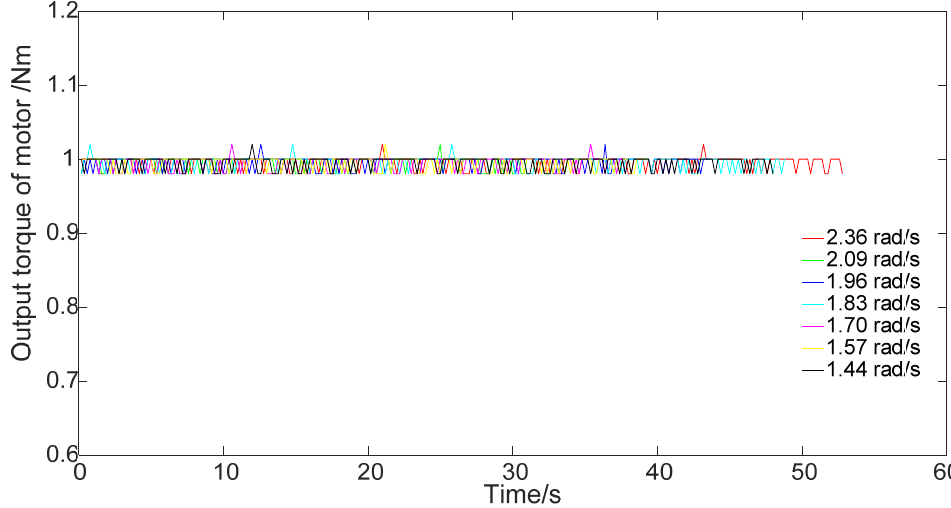
Figure 4. Torque-speed-time relationship of friction in harmonic drive.